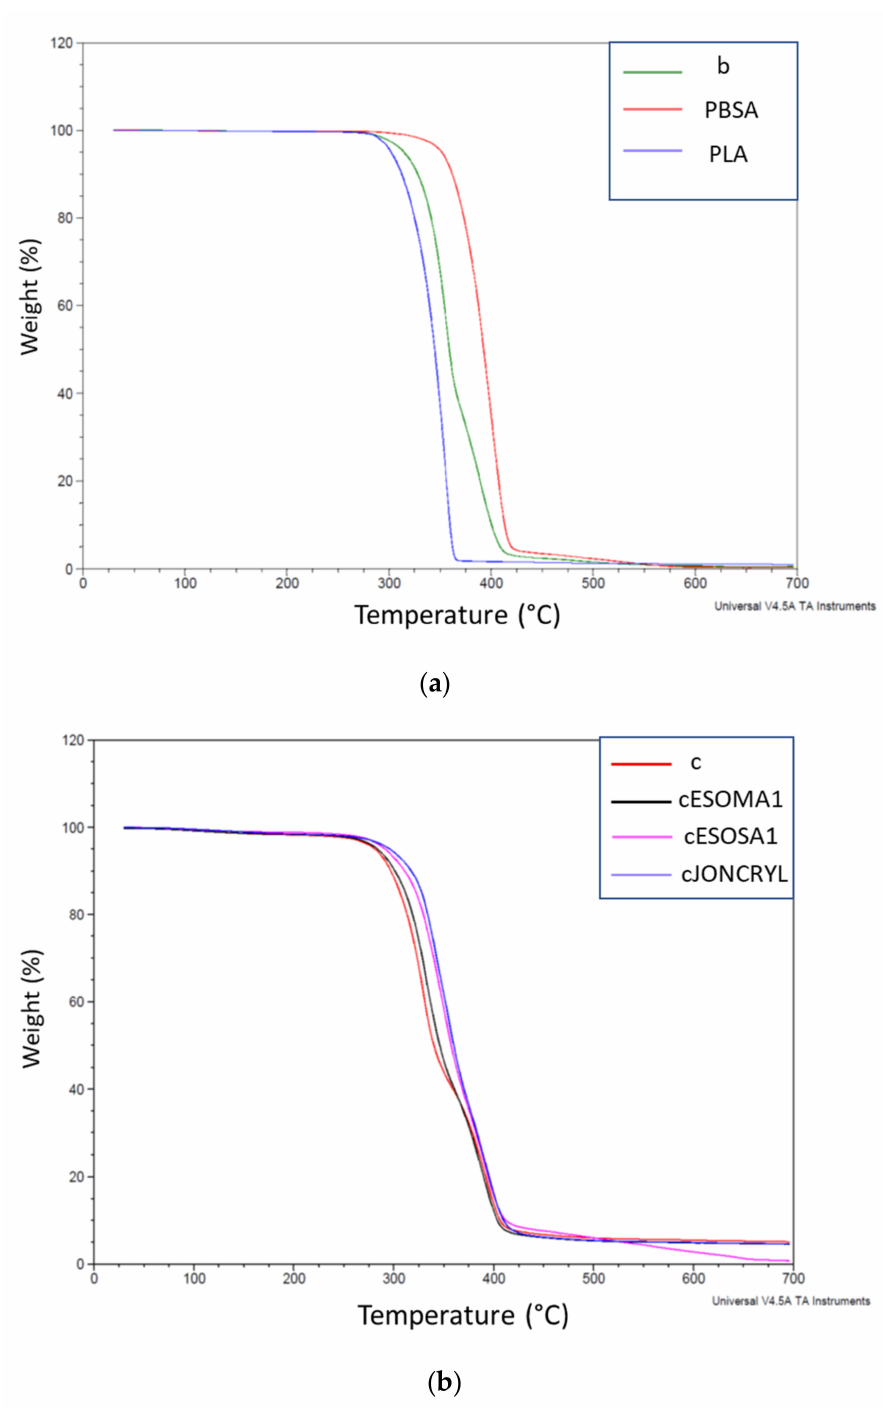
Figure 11. Thermograms of ( a ) pure polymers and ( b ) PLA/PBSA 60/40